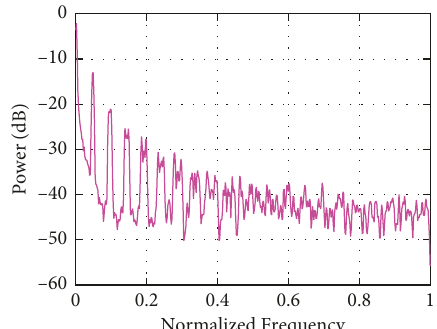
Figure 5: The normalized frequency.